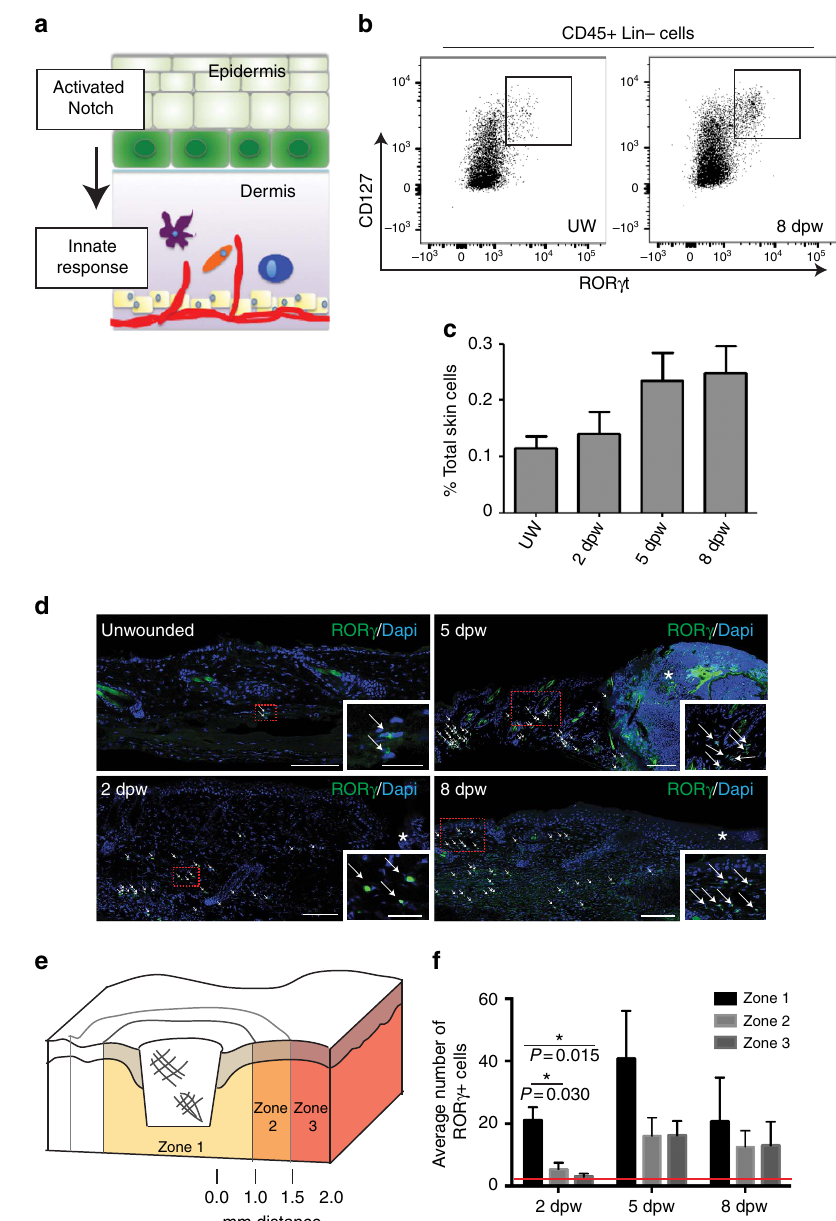
Figure 2 | ILC3s populate dermis in response to skin wounding. ( a ) Schematic of experimental hypothesis; Notch activation following injury in keratinocytes (green) induces innate immune cell recruitment (represented by purple, blue and orange cells) into the underlying dermis. ( b , c ) Dorsal back skin from UW or punch-wounded (4mm biopsy) wildtype animals were collected 2, 5 or 8 dpw. Whole back skin tissues were digested to single cell suspensions and co-stained with a lineage antibody panel (Lin) that react with cells from the major hematopoietic cell lineages and antibodies to CD45, CD127 and ROR g t. ( b ) Cells were first gated for CD45 þ and Lin–, then analysed for co-expression of CD127 and ROR g t. ( c ) The percentage of CD45 þ Lin (cid:3) CD127 þ ROR g t þ cells (ILC3s) in the total cell population was calculated for UW or wounds 2, 5 and 8 dpw. Per cent (%) total skin cells; averages of three biological replicates. ( d ) Back skin sections from unwounded mice or from punch-wounded (4mm) tissues collected 2, 5 or 8 dpw stained with an antibody to ROR g (green). Embedded insets are higher magnification images of the boxed region in the accompanying panel. ROR g þ cells are marked by white arrows and wound site marked by white asterisk. ( e , f ) Quantification of ROR g þ cells adjacent to wounds analysed by two-way ANOVA with statistical significance (marked with a single black asterisk, f ) between zones calculated by Bonferroni’s multiple comparison test. Zone 1 ¼ area from edge of wound to 1mm distal from wound edge, zone 2 ¼ region 1–1.5mm distal from wound edge and zone 3 ¼ region 1.5–2mm distal from wound edge. ( f ) Red line denotes average number of ROR g þ cells in unwounded dermis (1.47 ± 0.87 per mm 2 ). Graph bars are average cell numbers from 3 sections from 3 biological replicates; scale bars equal 100